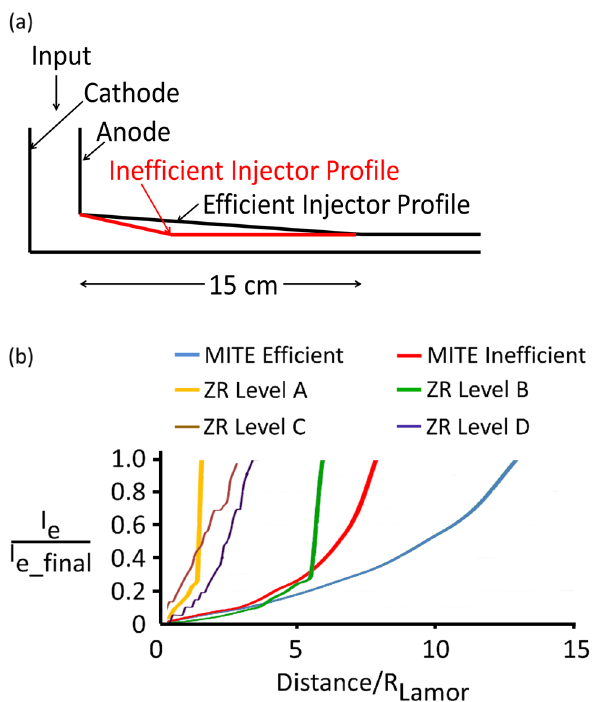
FIG. 5. (a) Cross section views of the inefficient and efficient injectors on MITE. (b) Normalized electron current versus normalized distance in the injector upstream from the uniform- gap MITL in MITE for an efficient injector (gap is tapered from 2 to 1 cm over an axial distance of 15 cm) and an inefficient injector (gap is tapered from 2 to 1 cm over an axial distance of 5 cm). The similar plots for the four MITLs in the refurbished Z Machine at peak voltage on the vacuum insulator are shown for comparison with a modern, load-dominated MITL